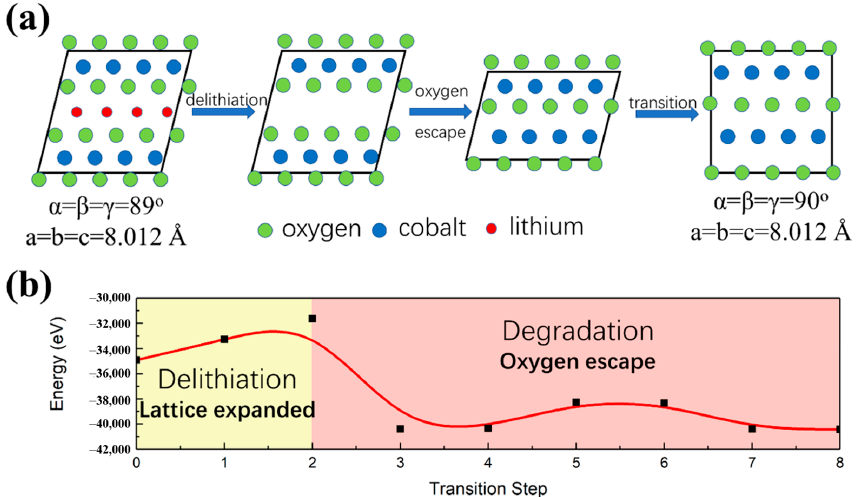
Figure 4. ( a ) Schematic diagram of electrochemically driven phase transition path from LiCoO 2 to Co 3 O 4 ; ( b ) calculated potential barrier along the proposed electrochemically driven phase transition path from LiCoO 2 to Co 3 O 4 .